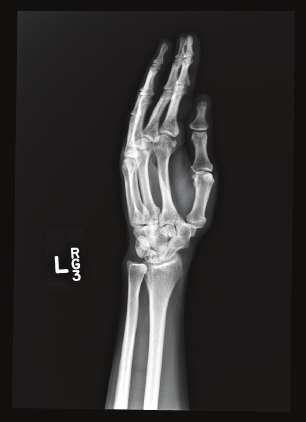
Figure 3: Oblique radiograph of the wrist demonstrates isolated scaphotrapezial